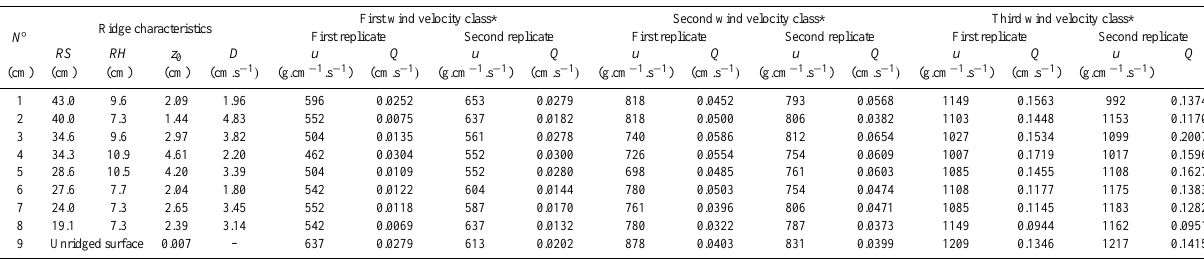
Table 2. Experimental data for horizontal flux measurements. Firstwindvelocityclass* Secondreplicate Firstreplicate Secondreplicate Firstreplicate Secondreplicate N ◦ Ridgecharacteristics RS